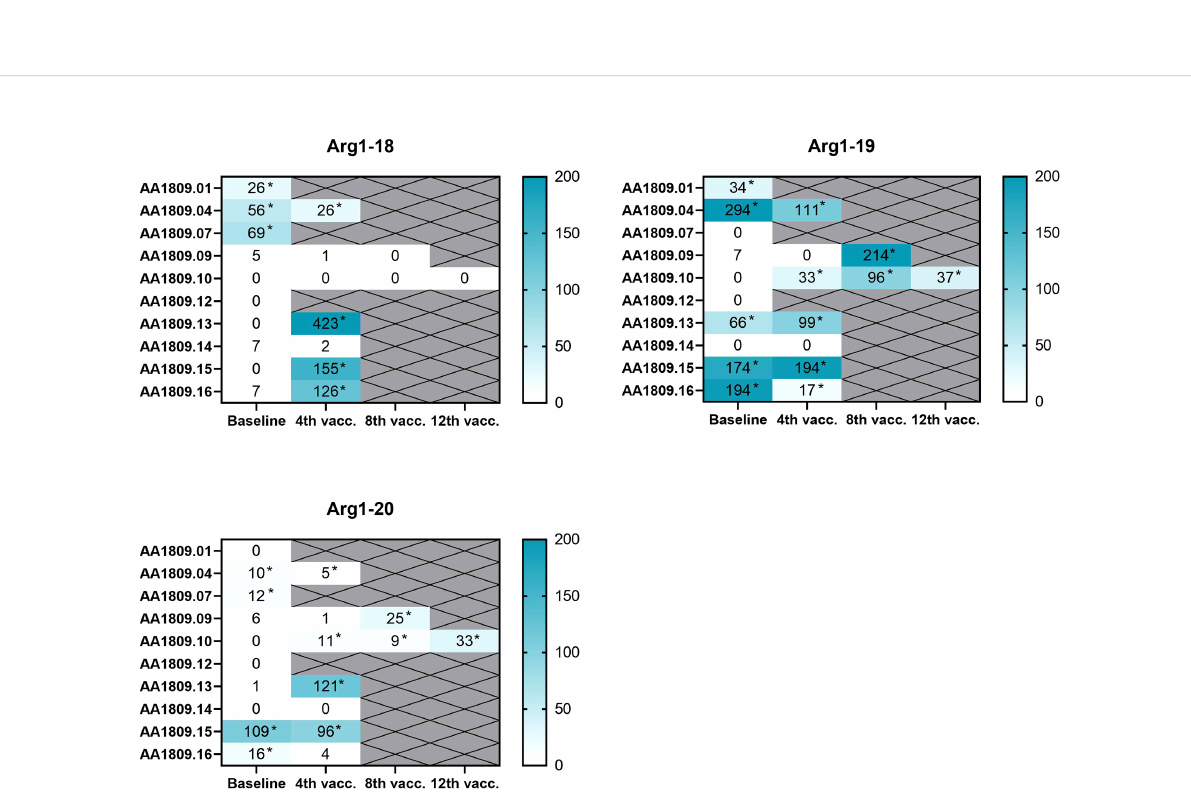
FIGURE 2 Heatmaps of detected speci fi c arginase-1 (ARG1) responses in peripheral blood mononuclear cells (PBMCs) at baseline and on treatment as measured by interferon (IFN)- g enzyme-linked immunospot (ELISPOT) assay (n=10). Background has been subtracted. *Indicates positive responses based on Distribution-free Resampling (DFR)